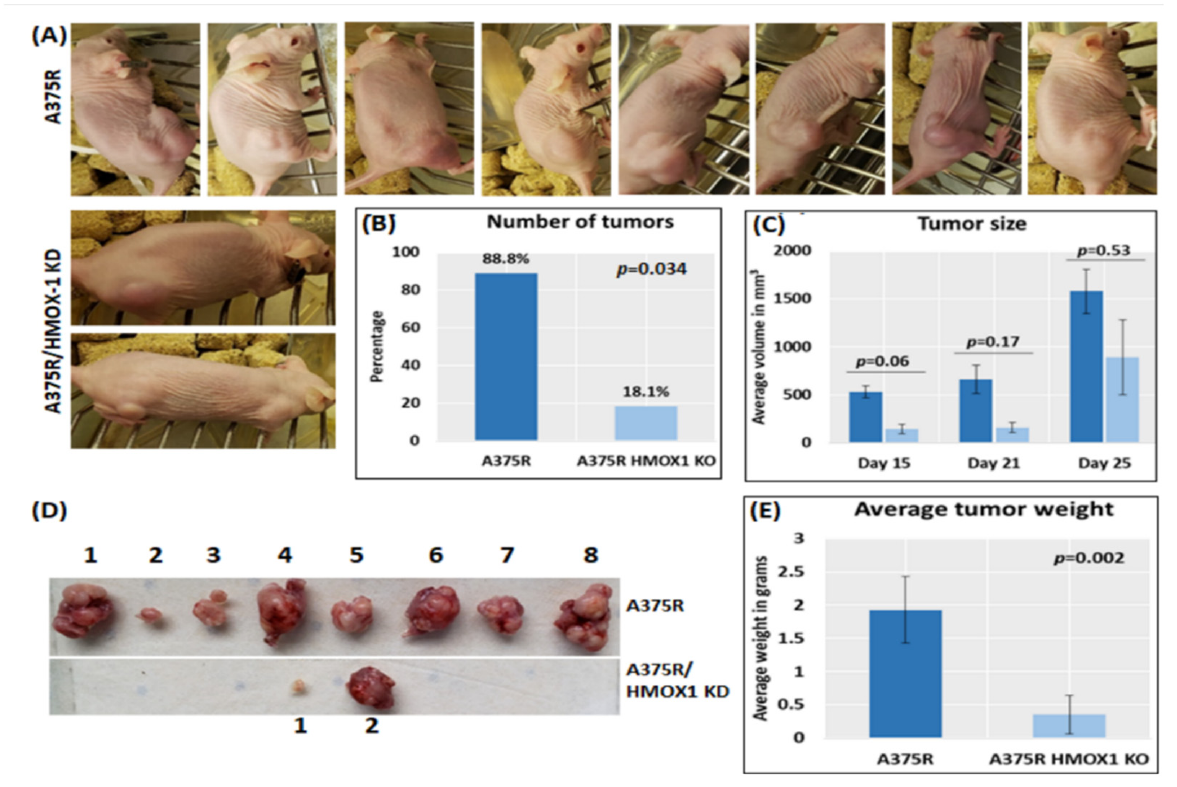
Figure 5. HMOX-1 knockdown reduces tumor growth in a melanoma mouse model. Mice were subcutaneously injected with A375R or A375R with HMOX-1 knockdown (2 × 10 6 cells/mouse). ( A ) Mice with visible tumors of each group. ( B ) Number of tumors per group. ( C ) Tumor size was monitored twice a week for 4 weeks. ( D ) Representative tumor images were taken from the HMOX-1 knockdown group and the control group. ( E ) The tumor weight was recorded at the end of the experiment (day 25).